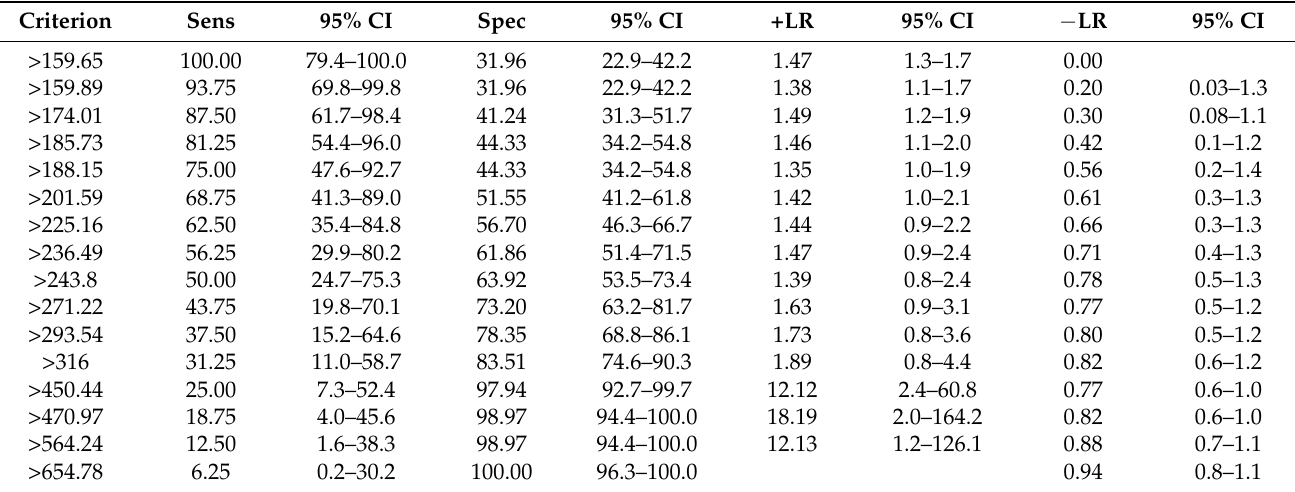
Table 3. Sensitivity/specificity table. Abbreviations: Sens—sensitivity; Spec—specificity; LR—likelihood ratio.